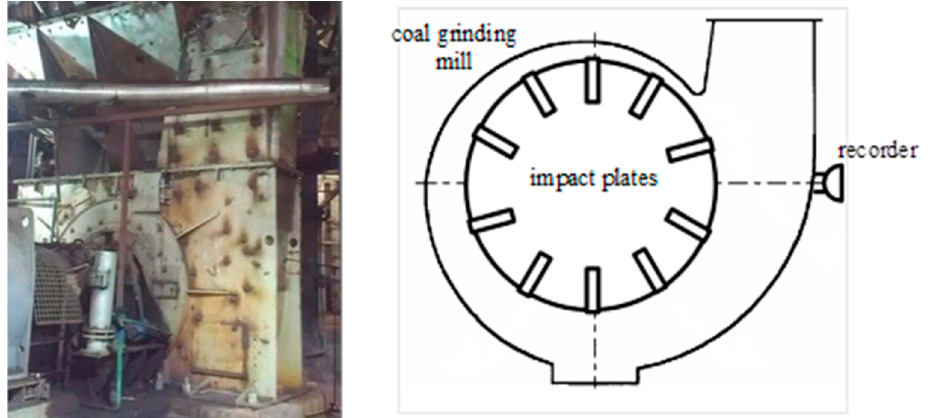
Figure 12. Coal grinding mill ( left ) and its cross section ( right ) [14].